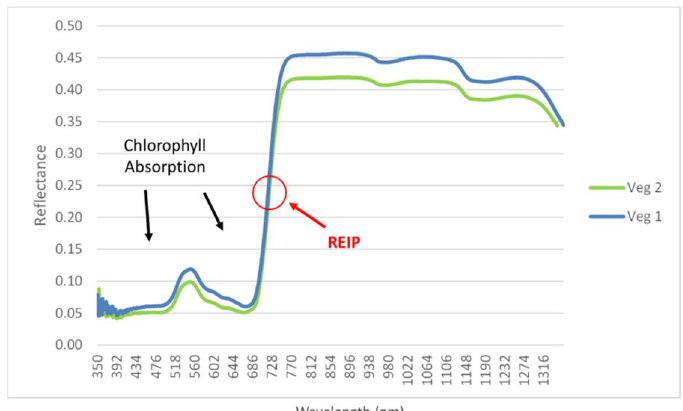
Figure 7. Spectral response of vegetation with the position of red edge inflection point (REIP) (Source of spectra: ASD FieldSpec Spectroradiometer acquisitions by CNR-IMAA)